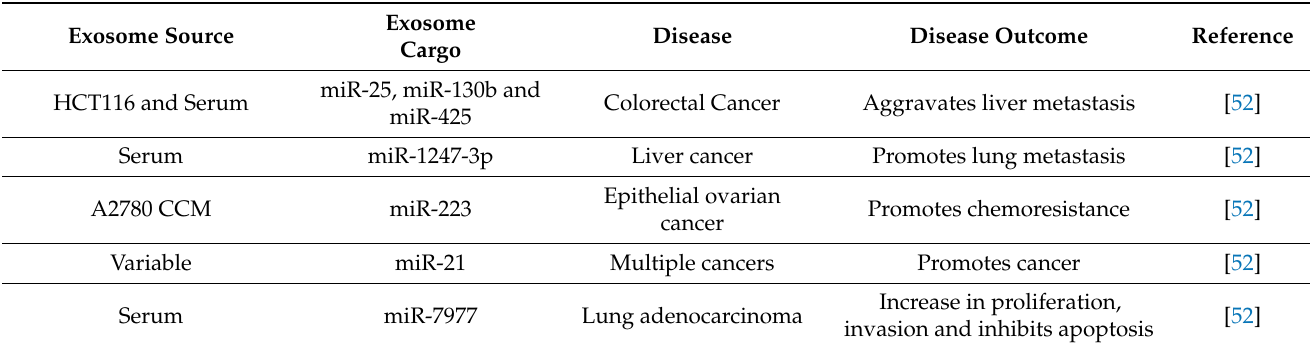
Table 1. List of exosomal RNAs in the occurrence of